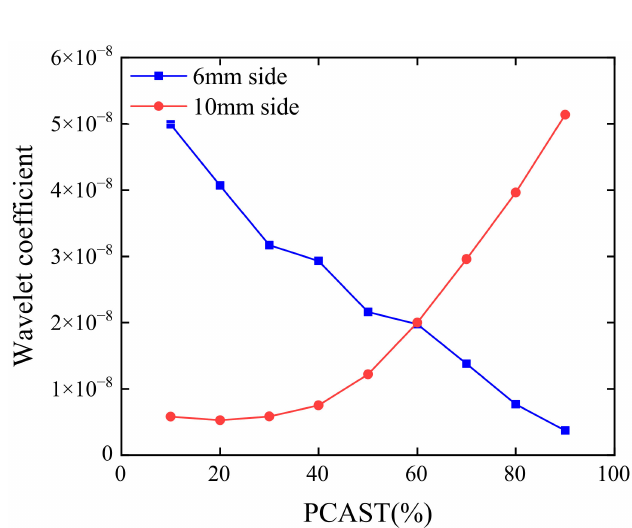
Figure 10. Change diagram of energy density